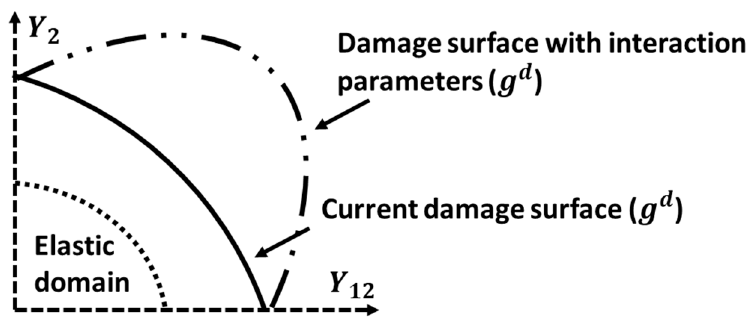
Figure 7. Damage surface with consideration of the interaction of damage parameters in the presence of multiple damage models in the thermodynamics space.